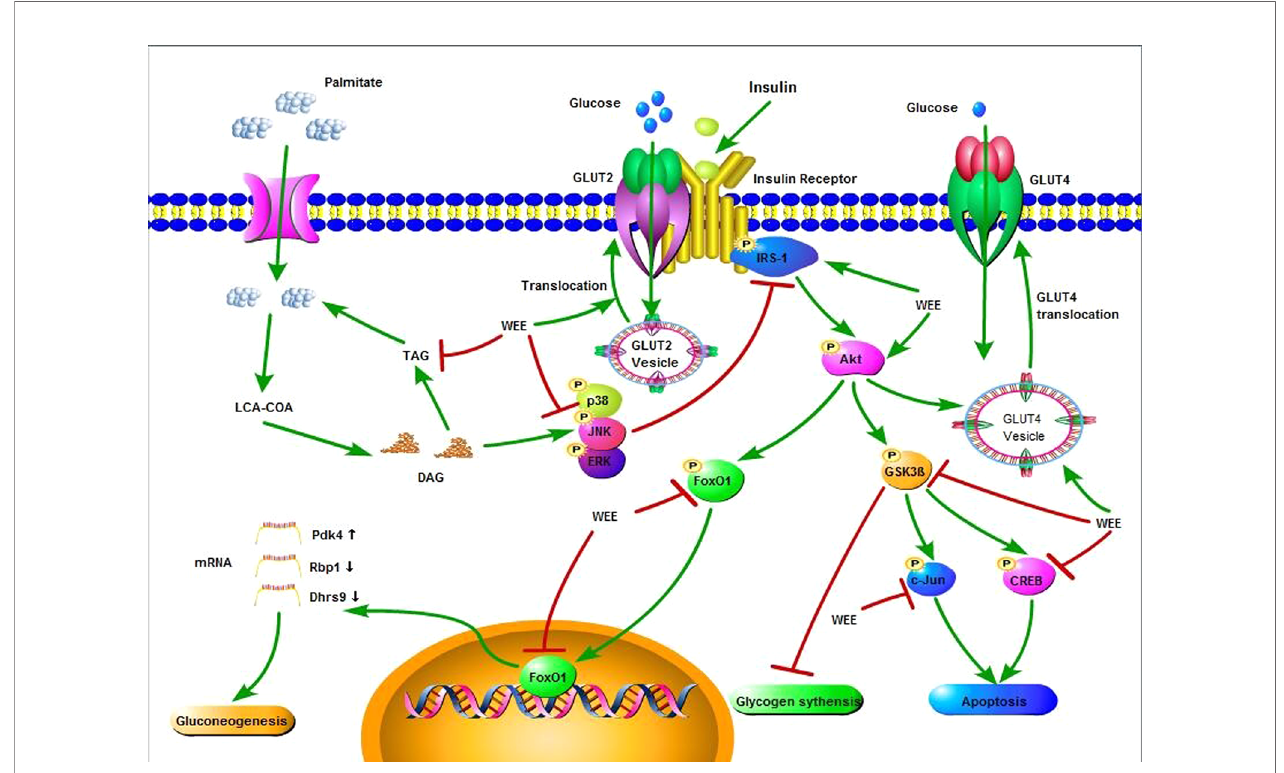
FIGURE 10 | Insulin signaling cascade targeted by WEE in PA treated HepG2